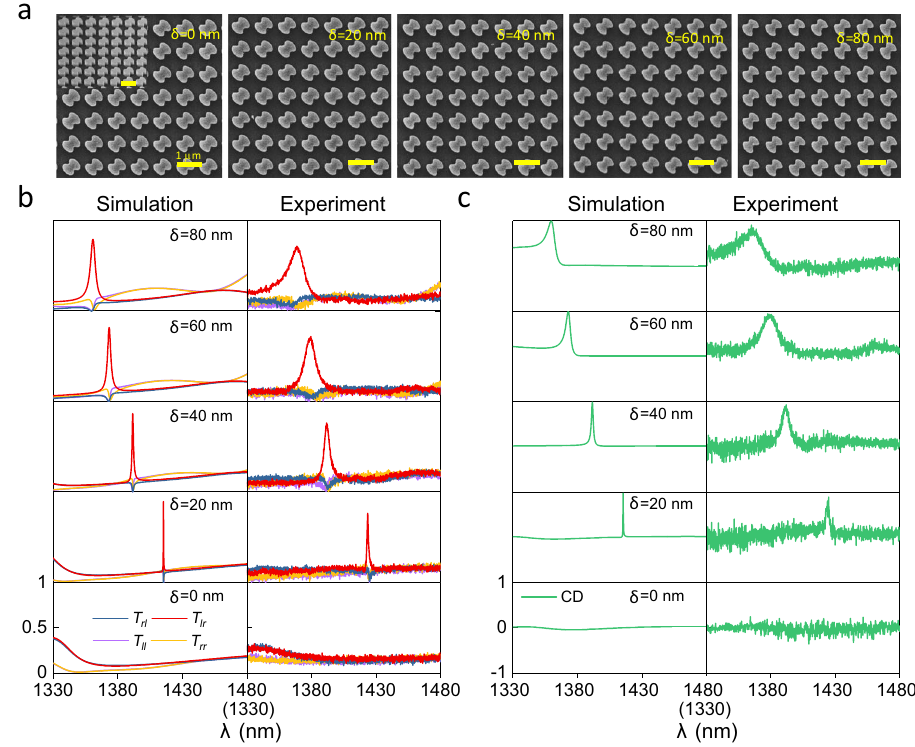
Fig. 4 Experimental veri fi cation of the intrinsic planar chiral q-BIC with various in-plane geometry asymmetry parameters. a The top view of the SEM image of fi ve fabricated DSS metasurfaces with asymmetry parameters δ = 0 nm, 20 nm, 40 nm, 60 nm, and 80 nm, respectively. The inset shows the slant view of the metasurface. Scale bar: 1 µ m. b Simulated and measured transmission Jones matrix spectra ( T lr , T rl , T rr and T ll ) of the fi ve DSS metasurface samples with different δ . c Simulated and measured CD spectra for different δ extracted from the Jones matrix spectra in ( b